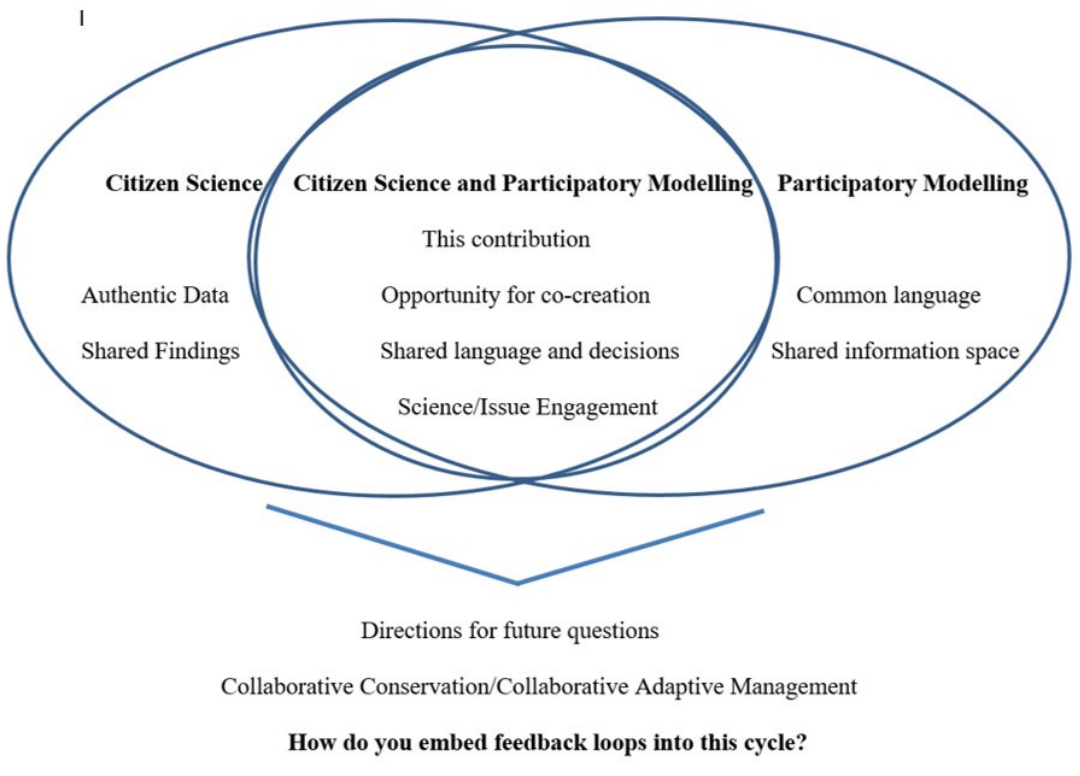
Figure 1. Citizen Science and Participatory Modelling overlap in the opportunities for collaboration and shared engagement in the sciences. This manuscript highlights the ways in which participatory modelling and Citizen Science practices complement each other in the interest of collaborative conservation and adaptive management. In particular, Citizen Science offers opportunities for authentic data gathering and shared results, whereas participatory modelling offers opportunity for common language establishment and shared information visioning and decision making. Critical for future research is the question of how does one embed feedback loops to ensure continued data collection and further refinement of the information that can be used to support decision-making.